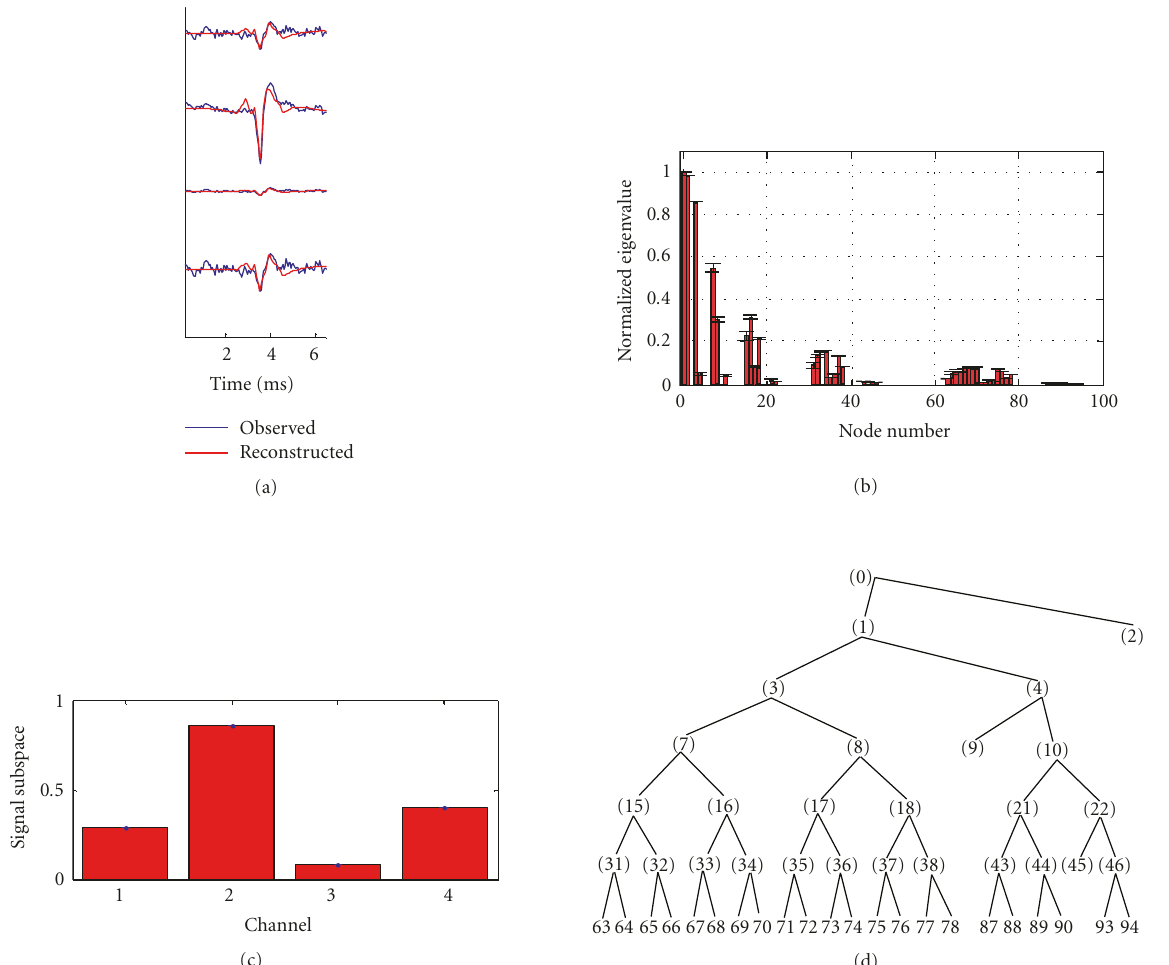
Figure 6: (a) Single source waveform along a 4-electrode array before and after best basis reconstruction (SNR = 5 . 7dB and 10 . 8dB, resp.). (b) Feature vector comprising sample mean of λ l 1 for 200 realizations, standard deviation is shown as error bars. (c) Sample mean of the principal eigenvector u l 1 . (d) Characteristic best basis wavelet packet